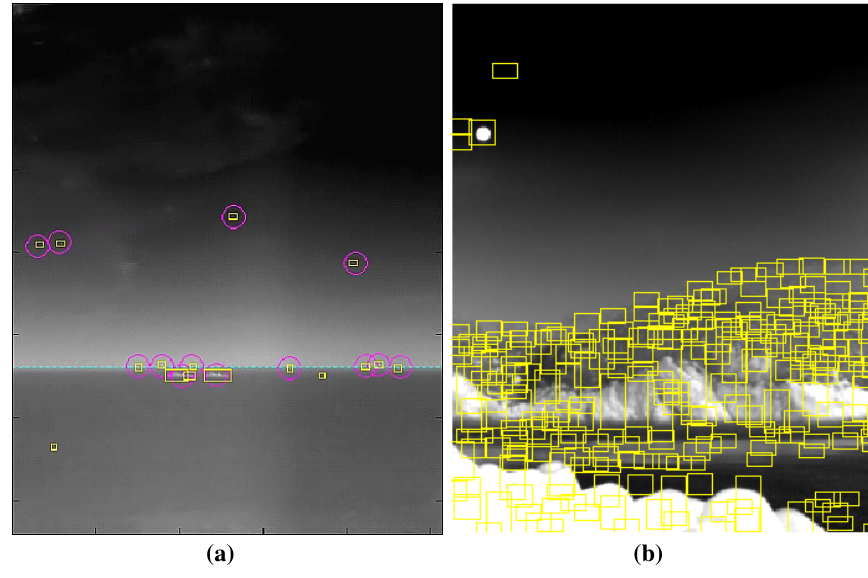
Figure 2. Comparison of spatial filter-based infrared target detection for different types of background: ( a ) sky-sea; ( b ) coast region. The yellow squares represent the detected target